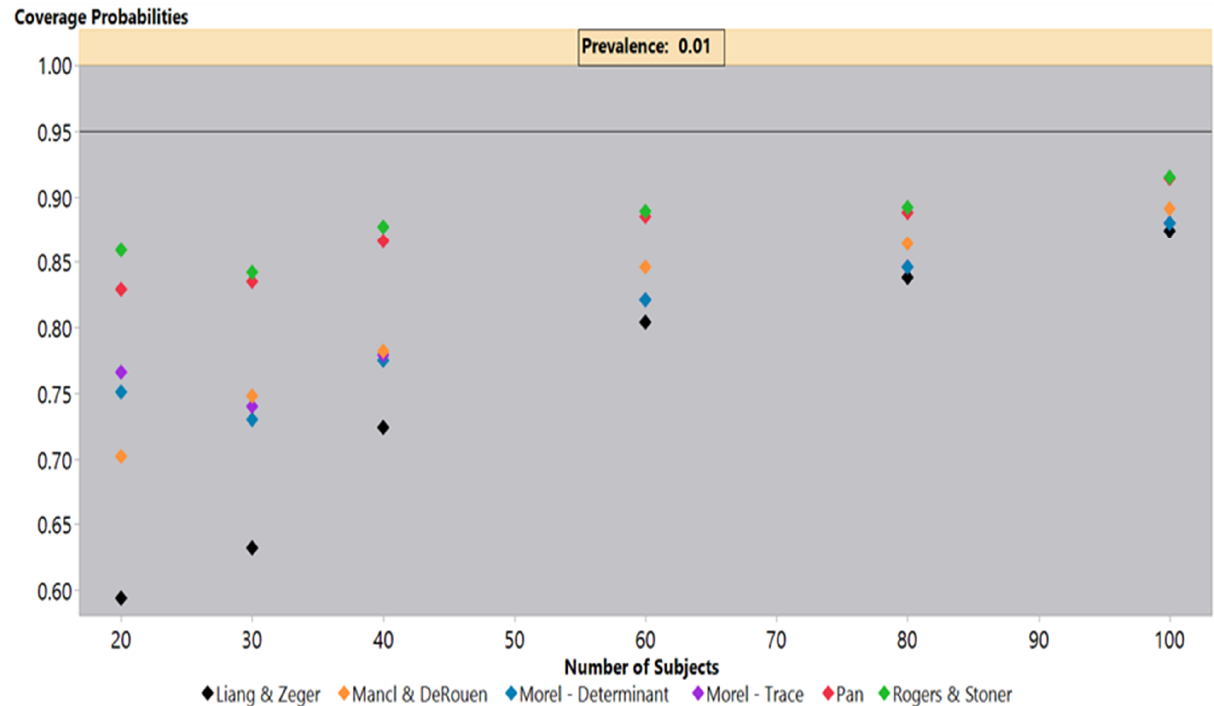
 under a simulated independence 1